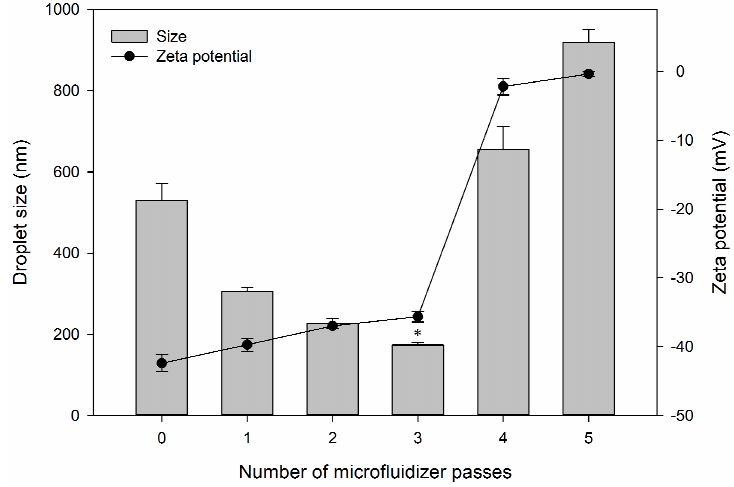
Figure 3. Effect of the number of microfluidizer passes on droplet size and zeta potential of methotrexate-loaded water-in-oil-in-water (W/O/W) nanoemulsion. Each value represents the mean and SD ( n = 3, at 25 °C). * p < 0.05 in droplet size. The composition of W 1 /O/W 2 emulsion consisted of 15% ( v / v ) for S mix , 2% ( v / v ) for W 1 , 8% ( v / v ) for O, and 75% ( v / v ) for W 2 . The ratio of methotrexate and oil was 1:2 ( w / v ).